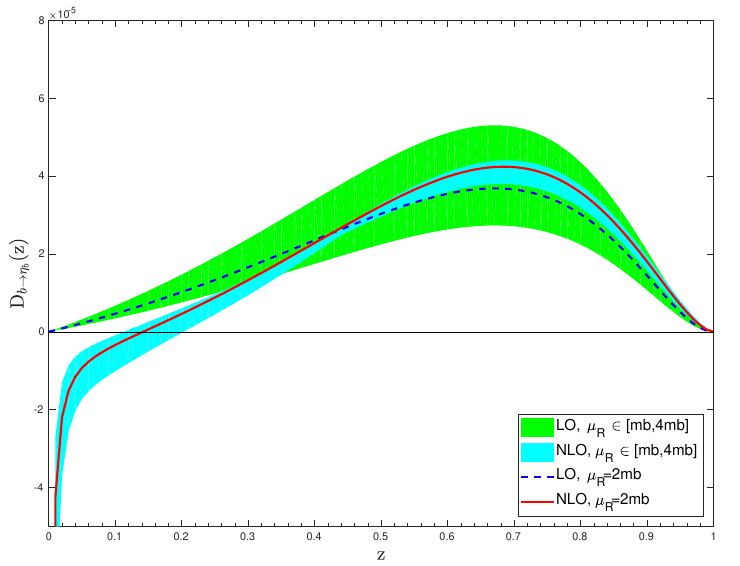
Figure 6 . The fragmentation function D b → η where µ F = 3 m b and µ R = 2 m b . The bands are obtained by varying the renormalization scale µ R by a factor of 2.